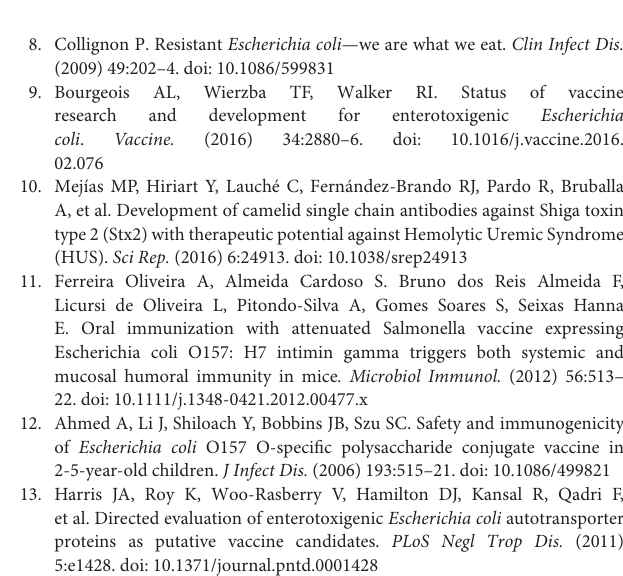
Supplementary Figure 1 | Predicted positions of MHC-I peptides (yellow color) in the 3D structure of HLA-B ∗ 44:03 receptor (red color), structures (A–F) are for epitopes number 1, 2, 3, 4, 5, and 6, respectively, from Supplementary Table 3 . Supplementary Figure 2 | Predicted positions of MHC-II peptides (yellow color) in the 3D structure of HLA-DRB1 ∗ 04:01 receptor (red color), structures (A–F) are for epitopes number 1, 2, 3, 4, 5, and 6, respectively, from Supplementary Table 3 . Supplementary Figure 3 | Graphical map for the designed multitope vaccine. Supplementary Figure 4 | The 3D model of the 9 predicted conformational B-cell epitopes in the refined final vaccine construct where the yellow residues